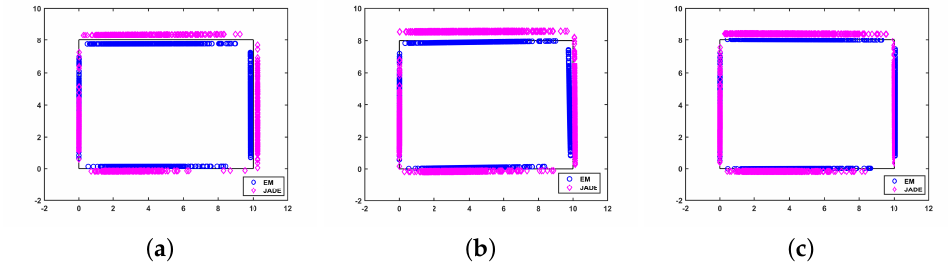
Figure 7. The mapping performance for different numbers of ADOA vectors: σ = 2 ◦ . ( a ) N = 200; ( b ) N = 500; ( c ) N =